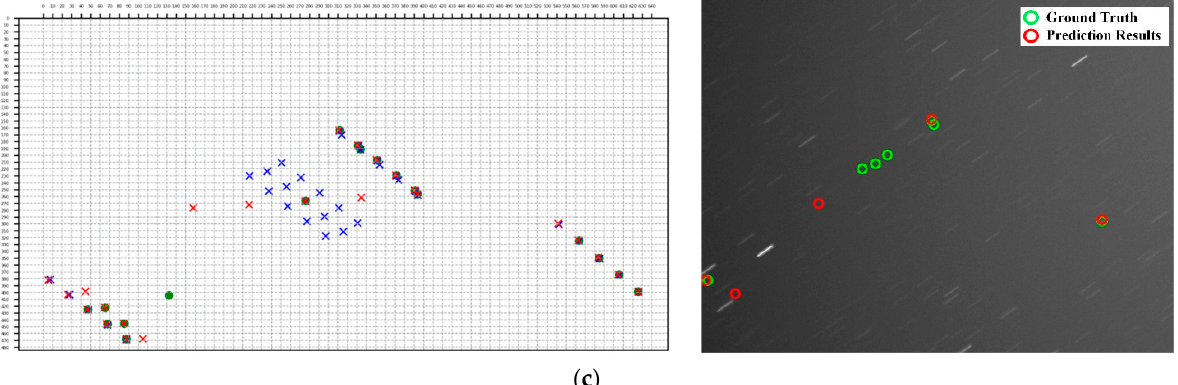
Figure 10. Visual examples of missed detection problem in the SpotGEO dataset: ( a )-( c ) show space targets that can't all be detected correctly in different spatial distribution within one sequence. Left column: the prediction results in terms of the sequence images. Right column: the first frame with